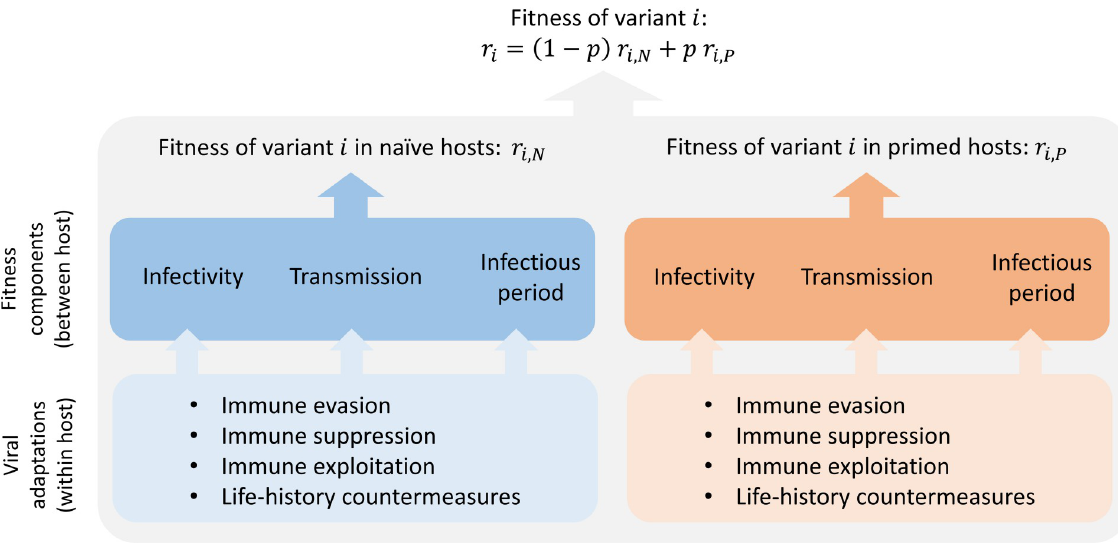
Fig 1. The fate of a variant ( i ) is determined by 3 key components of fitness, each of which can be affected by multiple within-host mechanisms of adaptation. All else being equal, variants with increased infectivity, increased transmissibility, or a long and early infectious period (i.e., long infections and a short generation interval) will have an increased fitness (rate of spread in a population). As indicated in Eq (1), fitness depends on both the degree of adaptation to na ï ve and primed hosts. Within-host processes affect the 3 components of fitness in each of the host types. Some within-host mechanisms of adaptation can be measured directly using in vitro assays. Some components of pathogen fitness can be inferred from evolutionary epidemiological